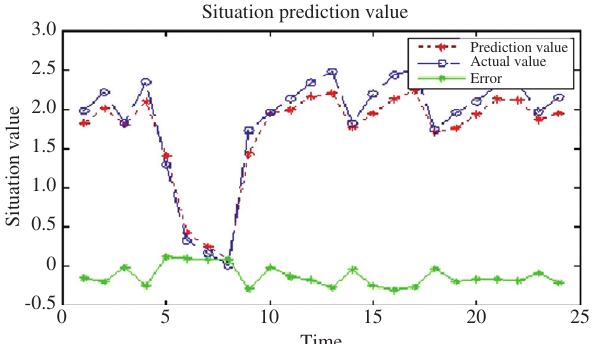
Figure 9. Prediction of the